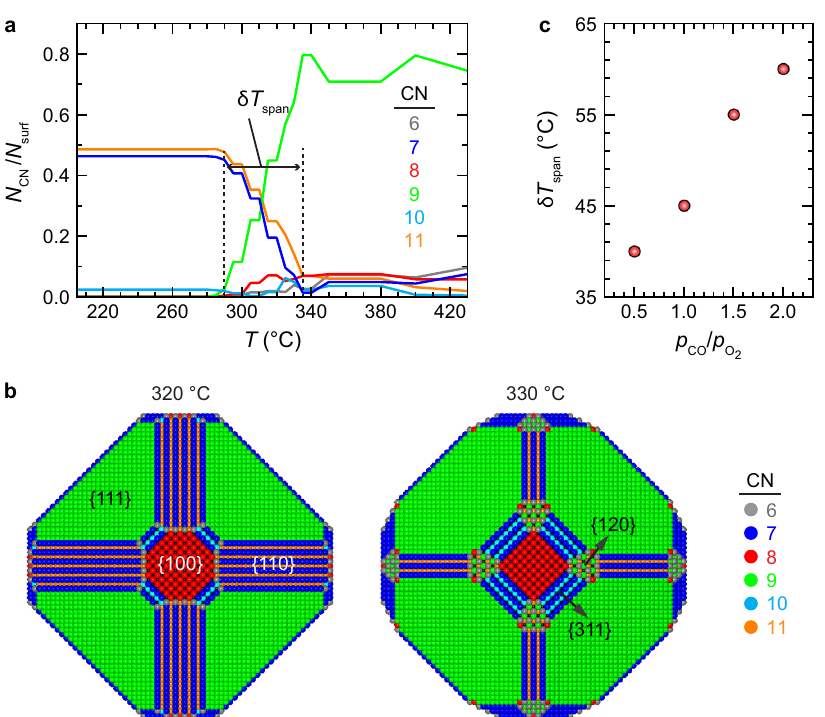
Fig. 5 | Modeling Pd NPs under reaction conditions. a Fraction of surface atoms accordingtotheircoordinationnumber,asindicatedinthelegendnexttotheNPs. with various coordination numbers (CNs) in Pd NPs, N CN = N surf , generated at The diameter of modeled NPs is between 13 and 15nm and they comprise around 60,000 atoms. c The thermodynamically calculated temperature spans ( δ T span ) =1 : 0,withO 2 partialpressure( p O )of140Torr. N surf isthetotalnumberof p CO = p O 2 2 surfaceatoms. Eachcolored line corresponds tothe fraction of surfaceatoms with where {110} dominant NP shape istransformed to {111} dominant one as a function (Fig. 5a and Supplementary Fig. a different CN. b Snapshots of the NP at 320 and 330°C. The atoms were colored of p CO = p O 2